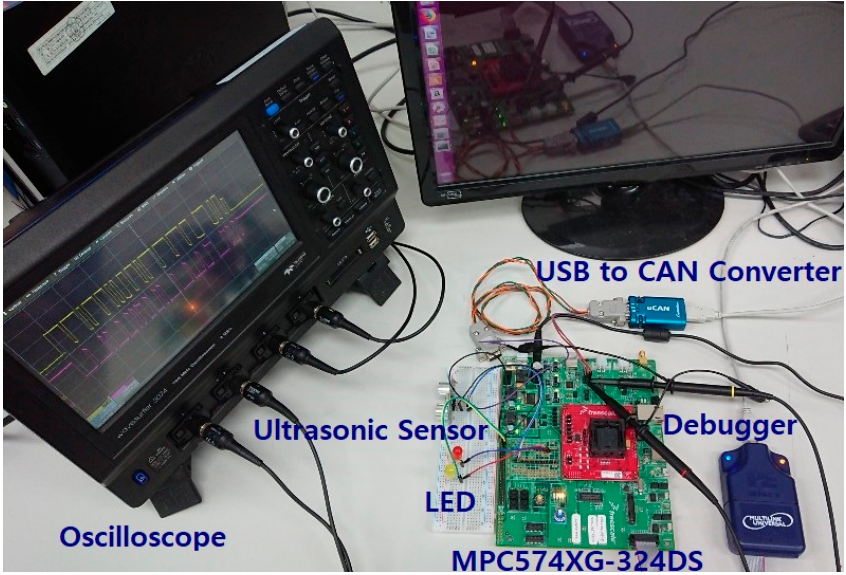
Figure 6. Hardware environment.